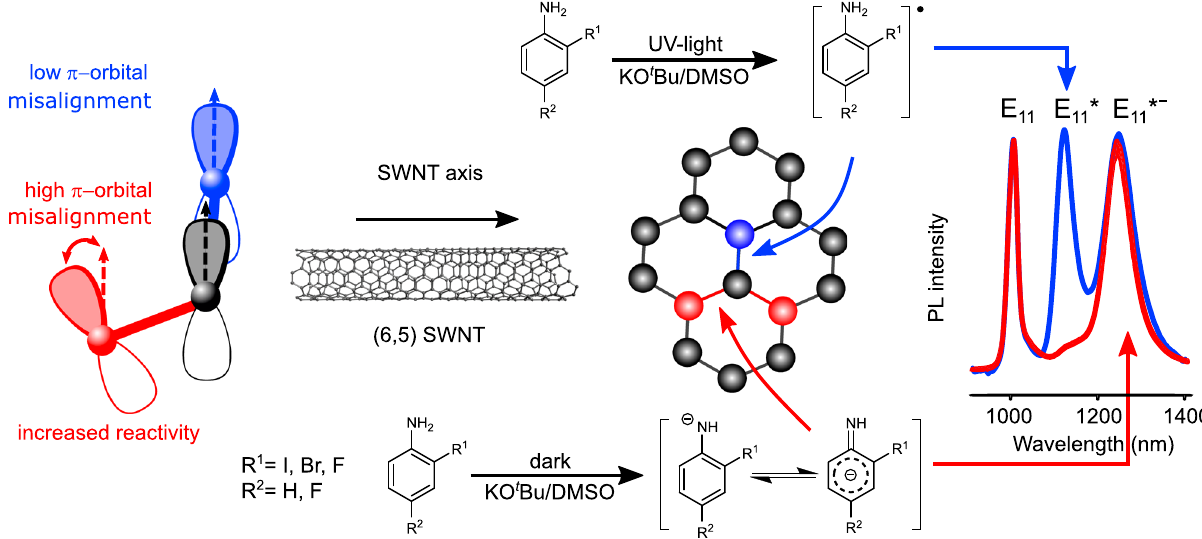
Fig. 6 Proposed functionalization mechanism for (6,5) SWNTs. Aniline derivatives can follow two reaction paths in the presence of KO t Bu and DMSO. Under UV-light irradiation, a radical species is formed that attacks the C – C bonds in circumferential direction, leading to the defect con fi guration for the E 11 * emission band (blue line). When the reaction is performed in the dark, deprotonation of the amine group and charge delocalization occurs. A nucleophilic attack on bonds with large π -orbital misalignment creates the defect con fi guration for the E 11 * − emission band (red line). Similar reaction paths are expected for phenols, thiophenols, and indoles with different carbanion intermediates. It is noteworthy that the deprotonated aniline species is in equilibrium with its protonated